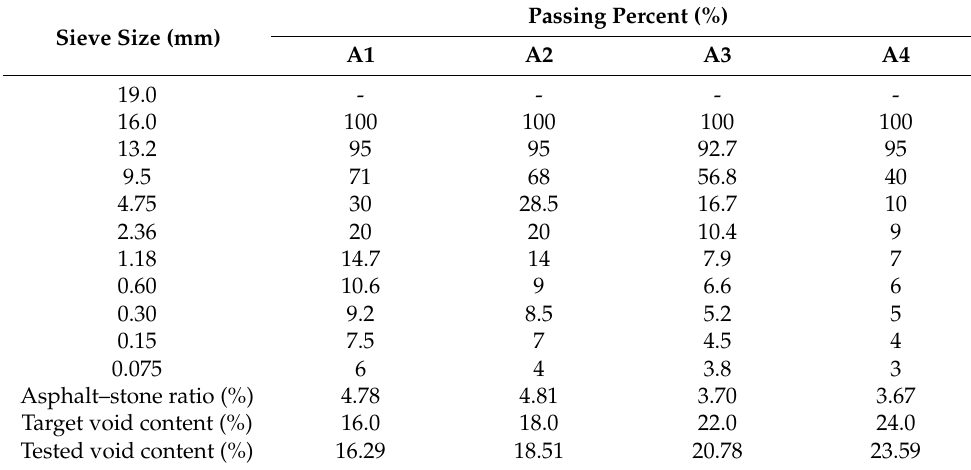
Table 4. Aggregate gradation of